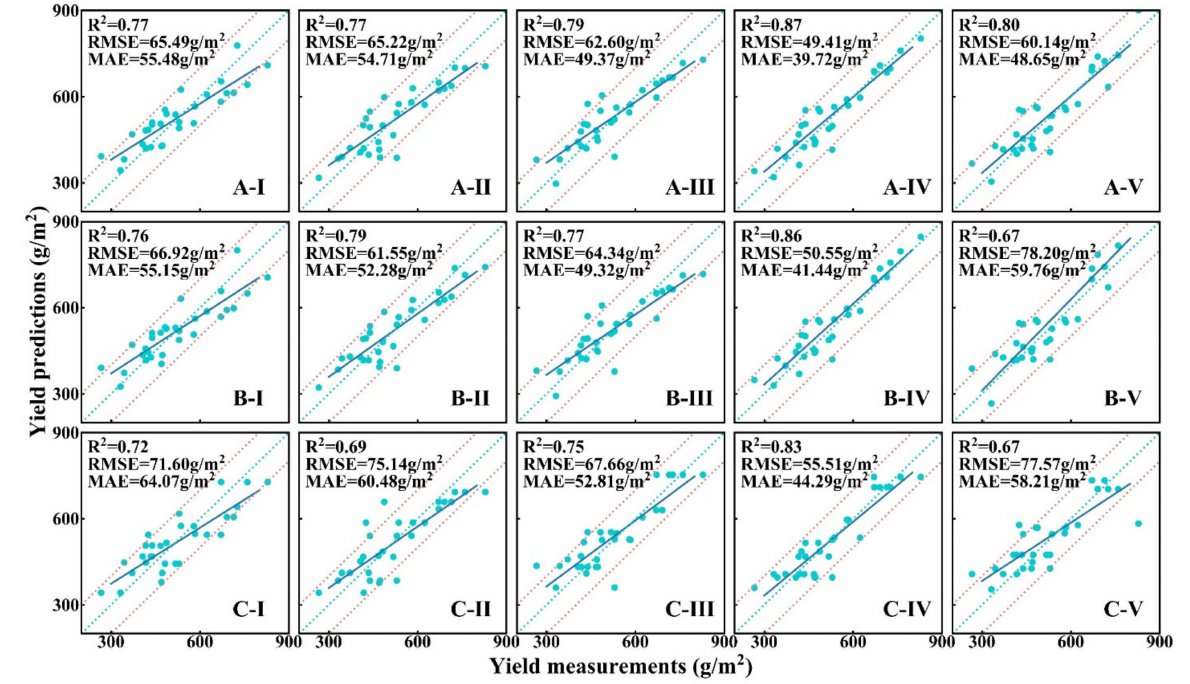
Figure 7. Scatter plots of the measured and predicted yield of the GPR, SVR and RFR models in the sampling square at each growth stage of winter wheat. Each point represents one sampling square ( A : GPR, B : SVR, C : RFR; I : jointing stage, II : heading stage, III : flowering stage, IV : filling stage, V : milk-ripe stage).